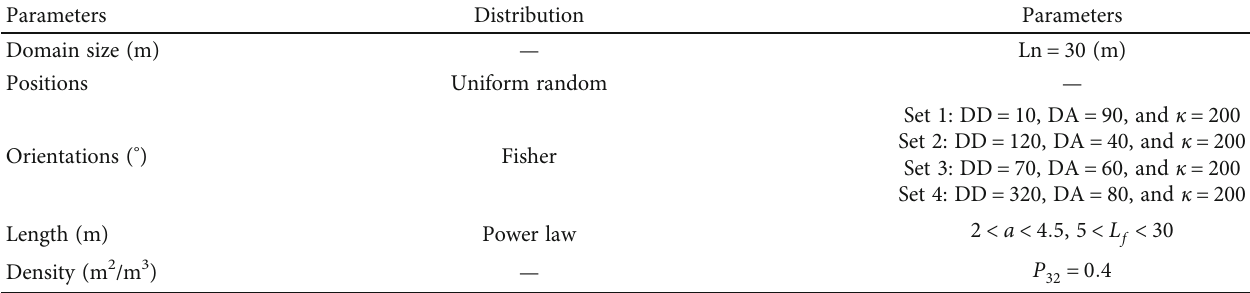
Table 1: Parameters used for the generation of DFNs in Section 2 (after Huang et al. [24]).